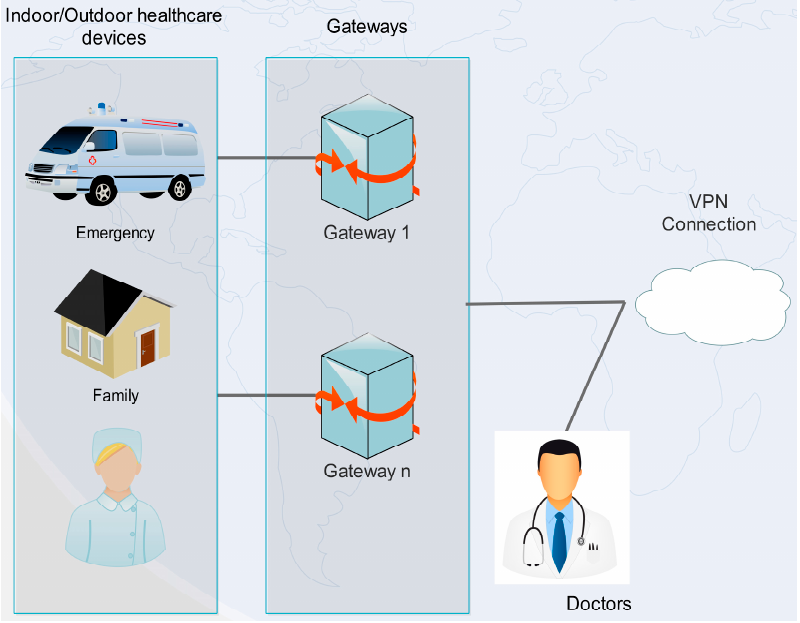
Figure 2. General remote healthcare monitoring system using VPN.